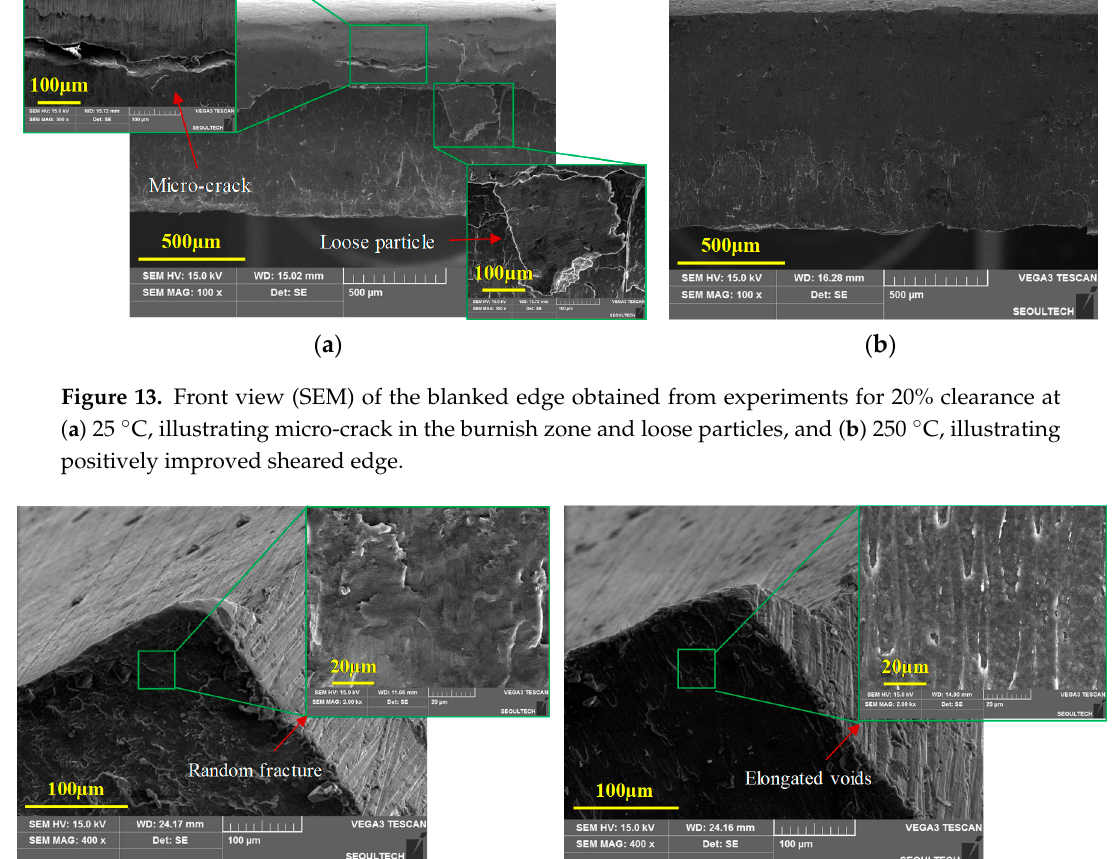
Figure 15. Schematic comparison of sheared edge profiles at temperatures ranging from 25– 250 °C and punch–die clearance of 20%. 3.2. Distribution of Edge Strain Hardening Index The mounted samples of the sectioned blanks were subjected to nanoindentations, using a micro-hardness tester. The value of the ESH index in Equation (1) was calculated and plotted against distance within the SZ and the SAZ. It can be observed that the hardness measurements are sensitive to the increase in temperature. One batch of samples with individual clearance was chosen to quantify the effect of temperature. Vickers hardness was measured as an average value of five measurements, performed separately